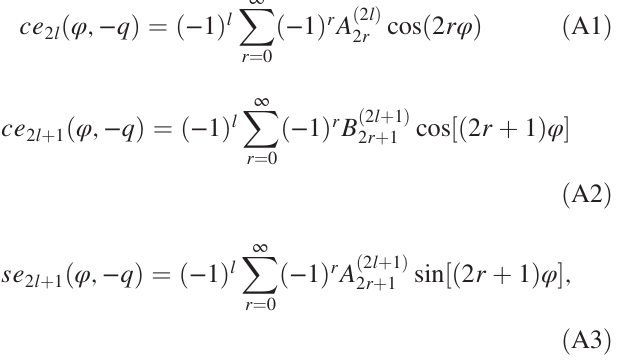
=b as a function of eq